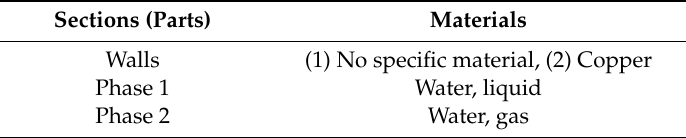
Table 1. Materials used in COMSOL